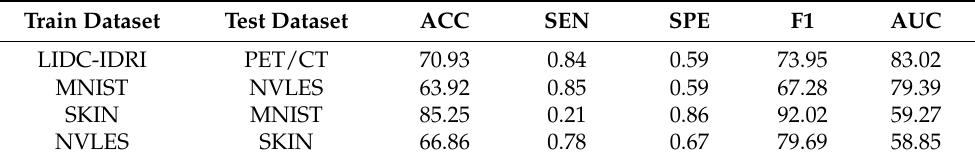
Table 10. Analytical metrics for the Xception network when evaluating on alternate acquisition device.